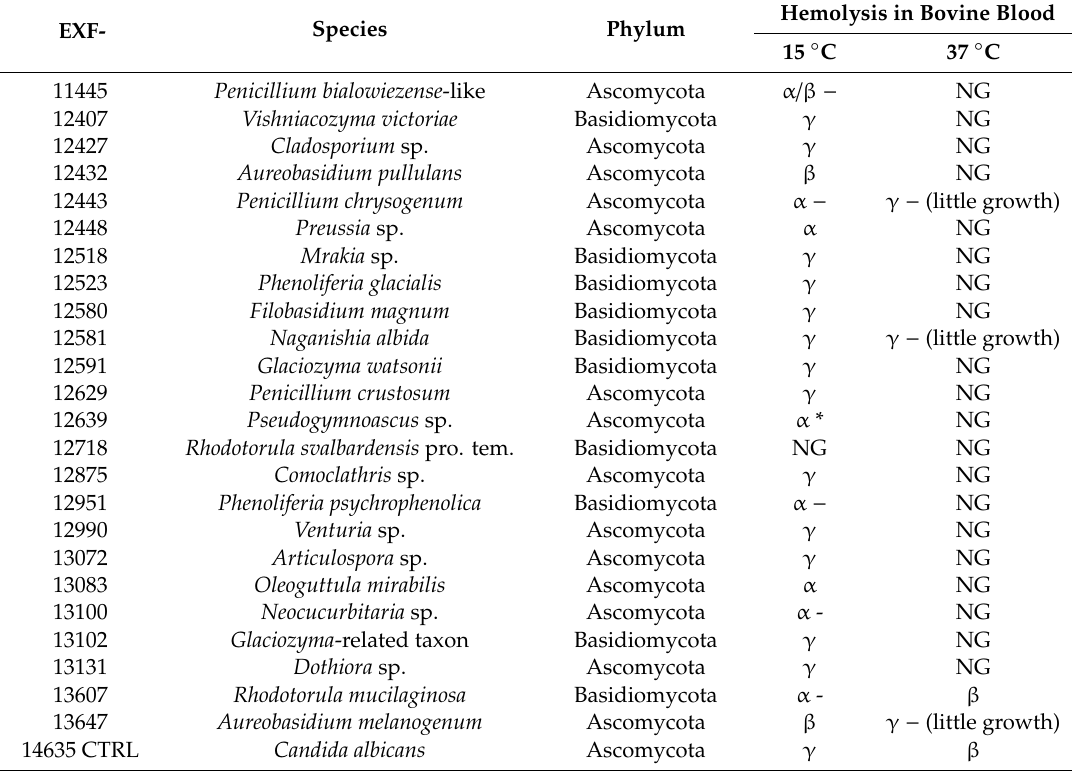
Table 4. Hemolytic phenotypes of the fungal species